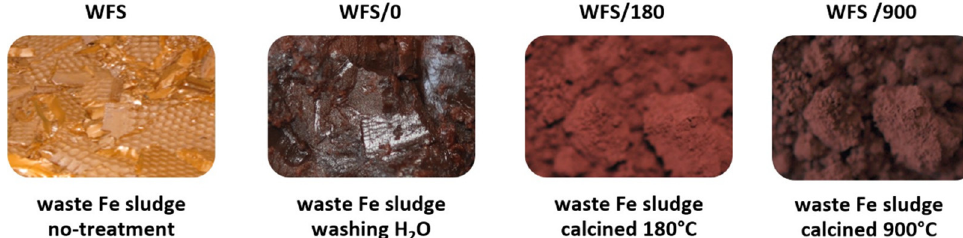
Figure 5. Form and color of the untreated waste Fe sludge (WFS), waste Fe sludge washed in water (WFS/0), waste Fe